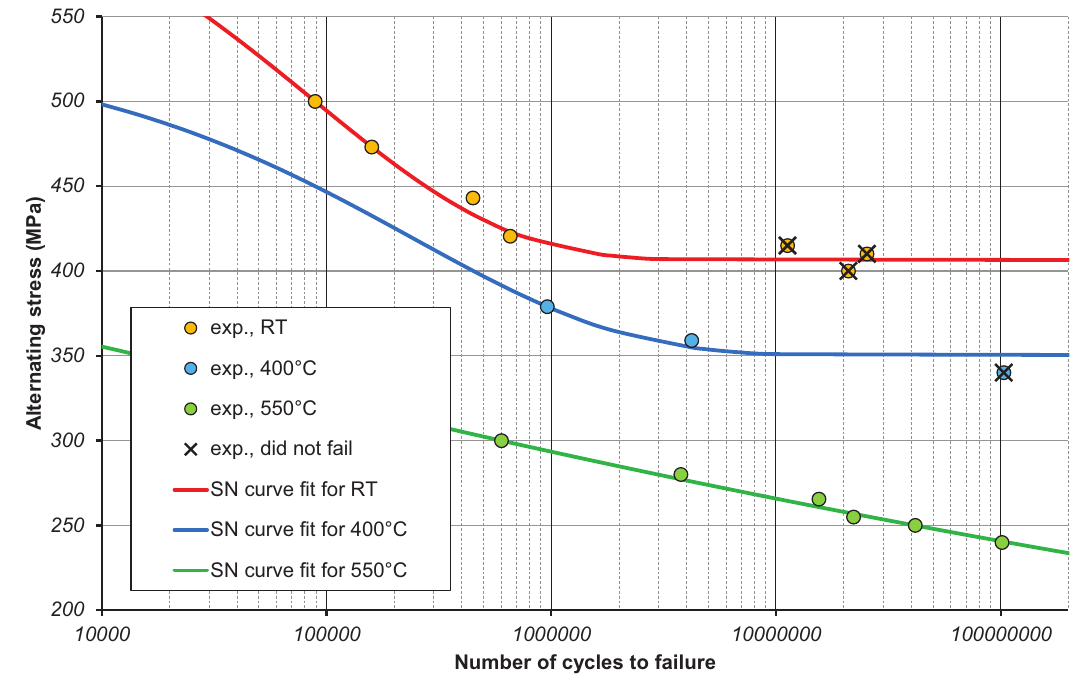
Figure 6: S-N curve fits of ASTM P91 steel based on HCF data by Matsumori et al. [35]